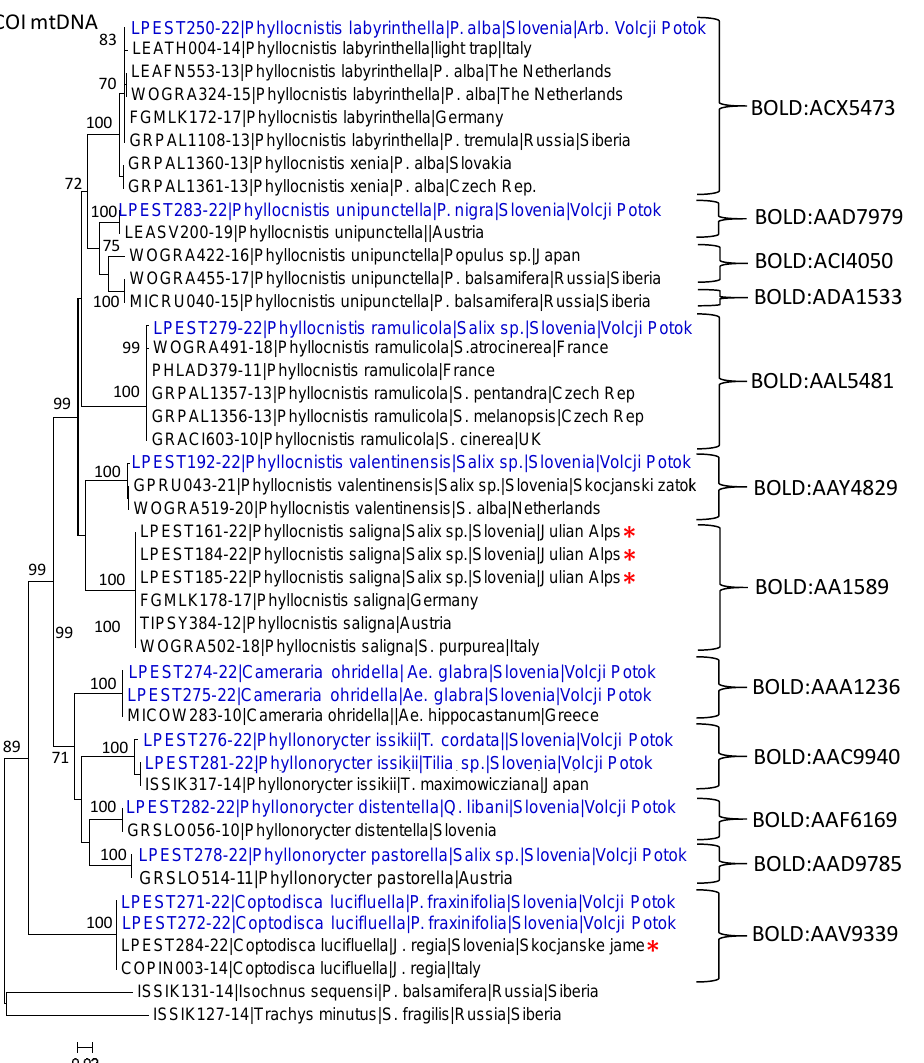
Figure 3. The maximum likelihood tree illustrating the relationship between the leaf-mining moths sampled in the Volčji Potok Arboretum, Slovenia (specimens indicated in blue), and those from other parts of Europe. Species BINs are indicated next to the species clusters on the right. Each specimen is identified by its process ID, leaf miner species name, host plants (genera: Ae.—Aesculus , J.—Juglans , P.—Populus , P.—Pterocarya , Q.—Quercus , S.—Salix , T.—Tilia ), and country. Additional specimens from Slovenia collected during the course of the study are indicated by a red asterisk (*). Bootstrap values > 70% are shown next to the branches.